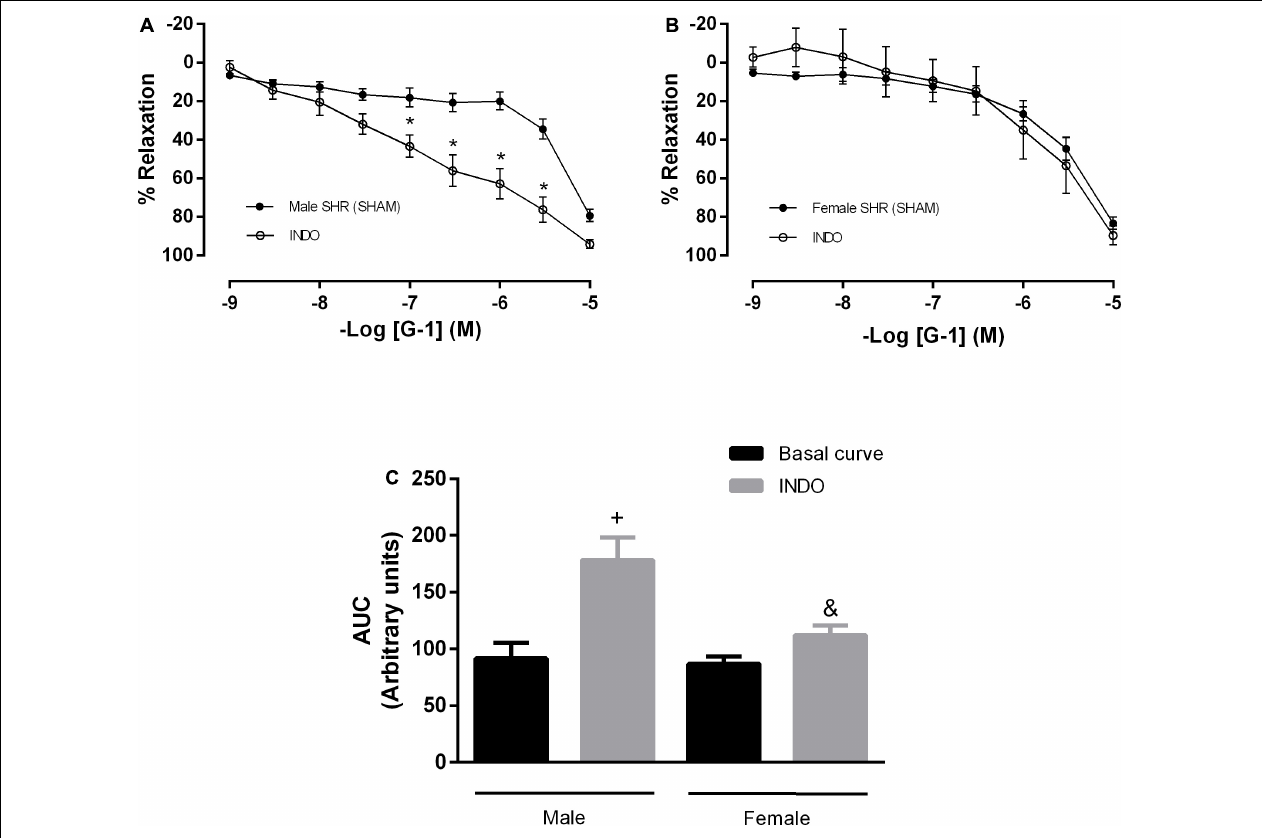
FIGURE 4 | The prostanoids pathway does not participate in the vasodilator response induced by G-1. However, nonspecific inhibition of cyclooxygenase potentiated this response in the Male SHR group. Effect of non-selective cyclooxygenase inhibition with indomethacin (INDO, 10 µ M) in (A) Male ( n = 8) and (B) Female ( n = 7) SHR groups. (C) Area under the curve (AUC) before and after INDO incubation. Values are expressed as the mean ± SEM. * P < 0.05 compared to the same dose in the control curve, + P < 0.05 compared to the AUC of the Male SHR control curve and & P < 0.05 compared to the AUC of the Male SHR group after INDO incubation. The curve analysis was carried out point-by-point through two-way ANOVA, followed by the Sidak post hoc test. AUCs were evaluated through one-way ANOVA followed by Tukey post hoc test.